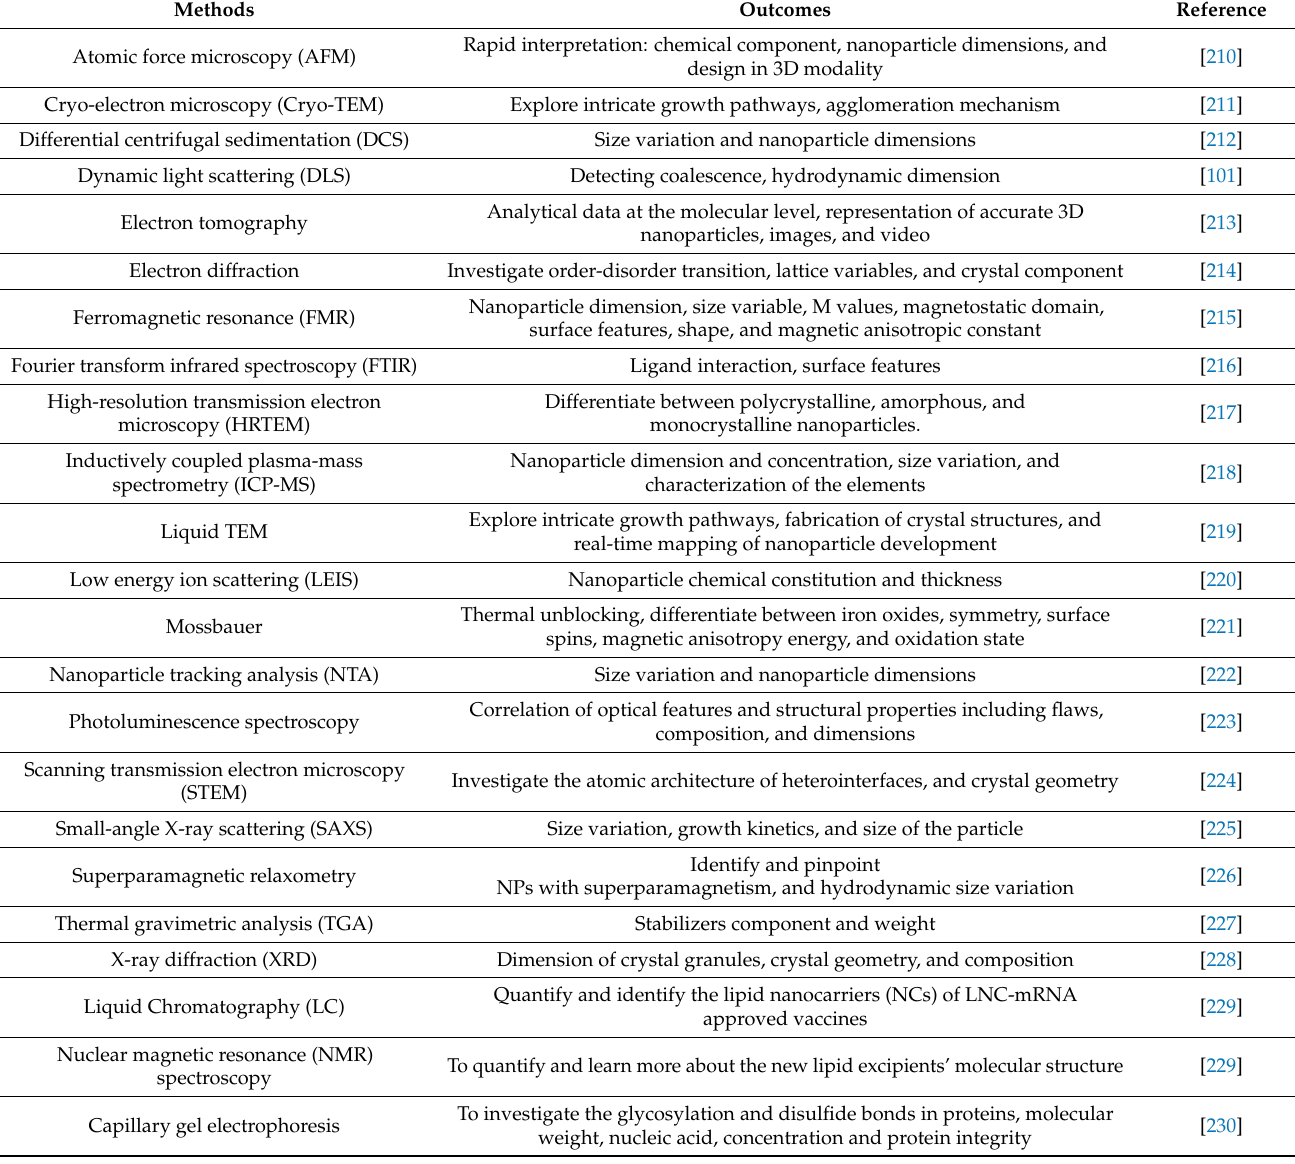
Table 3. The empirical approaches used to characterize NPs are